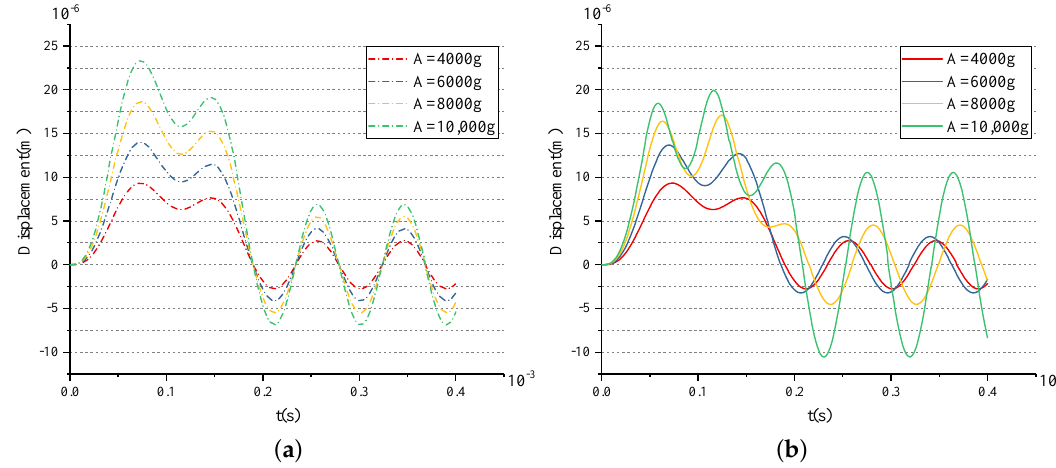
Figure 9. The results of the Simulink model of the shock response of the MEMS gyroscope: ( a ) without the stopper mechanism and ( b ) with the two-stage elastic stopper